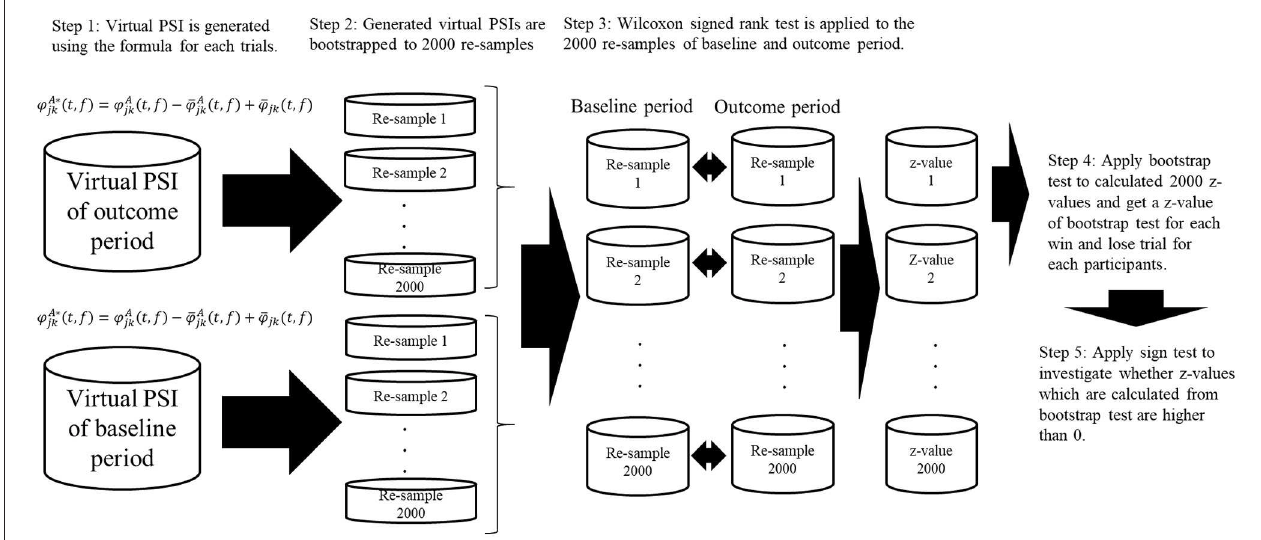
FIGURE 2 | Schematic illustration of bootstrap procedure of phase synchronization index (PSI) and cross frequency coupling. Virtual PSIs are created by using the formula and 2,000 bootstrapped re-samples are created using the virtual PSIs for baseline period, outcome period for each trials of win and lose. After calculating the bootstrapped re-samples, non-parametric Wilcoxon signed-rank test was applied to the produced virtual PSIs and z -values are calculated. Then we applied bootstrap test to these z -values. After calculating the z -values from bootstrap test, we applied sign test to bootstrap test z -values to investigated whether they are significantly higher than